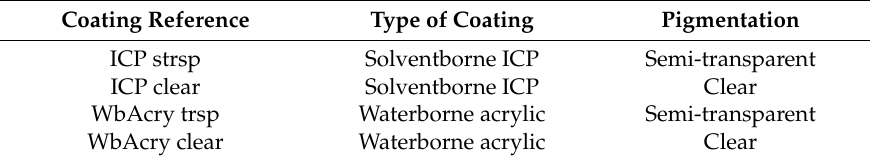
Table 1. Description of the four tested coatings.